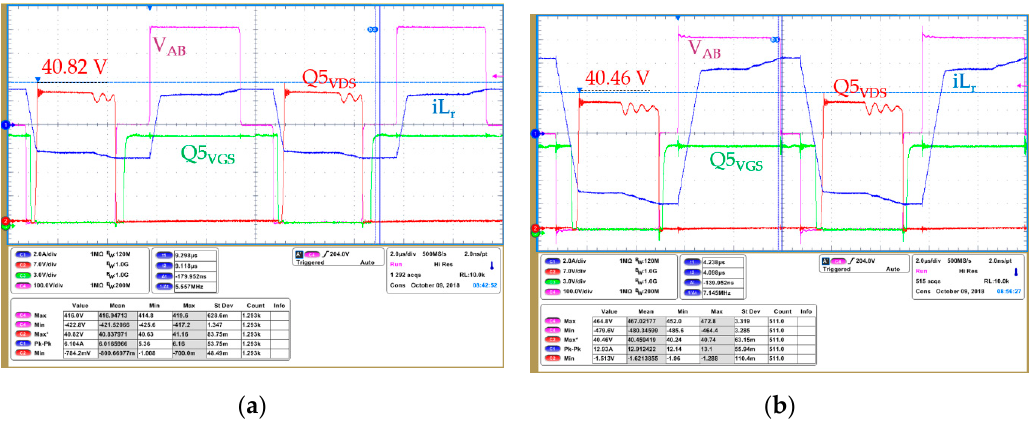
Figure 28. SRs drain voltage overshoot: ( a ) Working at 140 W of output power (10% of load); ( b ) working at 1400 W of output power (full load).